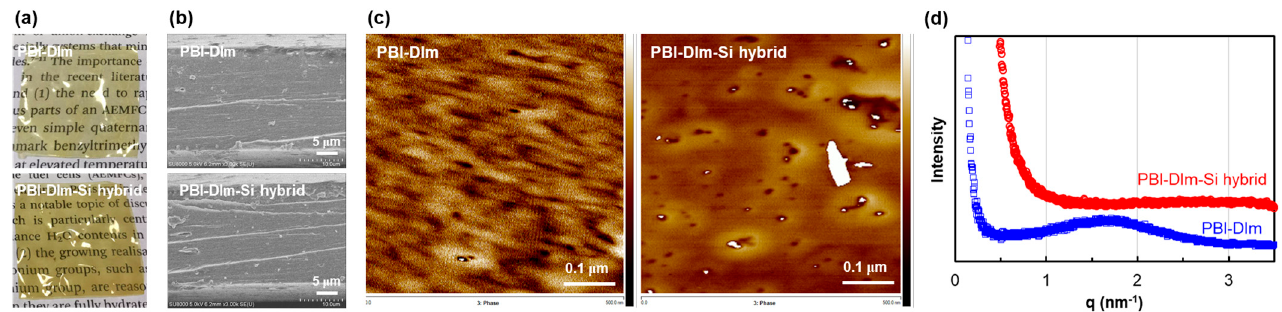
Figure 4. ( a ) Photographs, ( b ) SEM cross-sectional micrographs, ( c ) AFM phase images of the PBI-DIm and PBI-DIm-Si hybrid membranes, and ( d ) SAXS profiles of PBI-DIm and PBI-DIm-Si hybrid membranes.